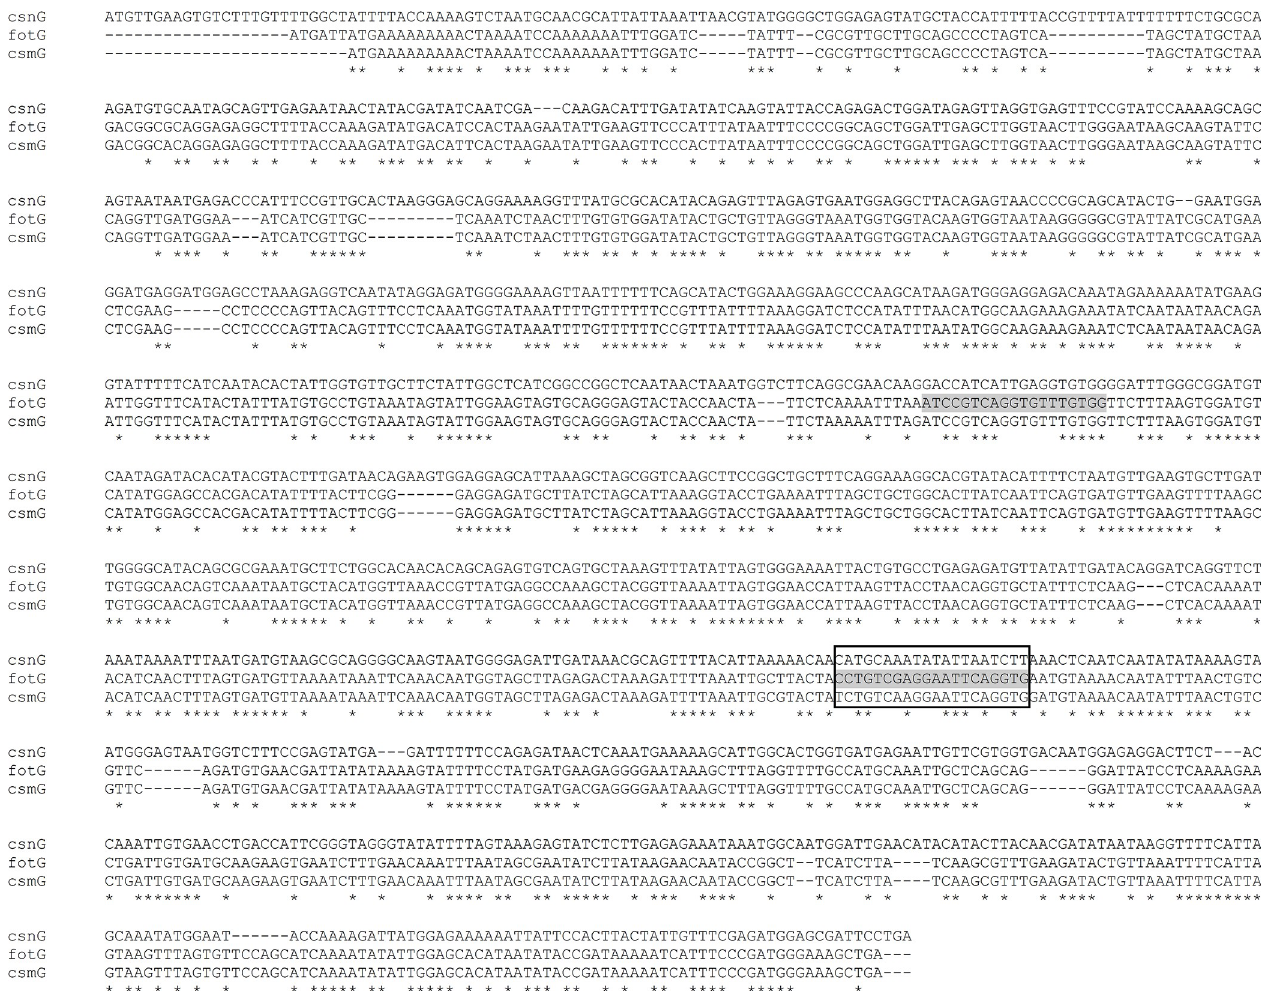
PLOS NeglectedTropical Diseases | https://doi.org/10.1371/journal.pntd.0007037 January 4,